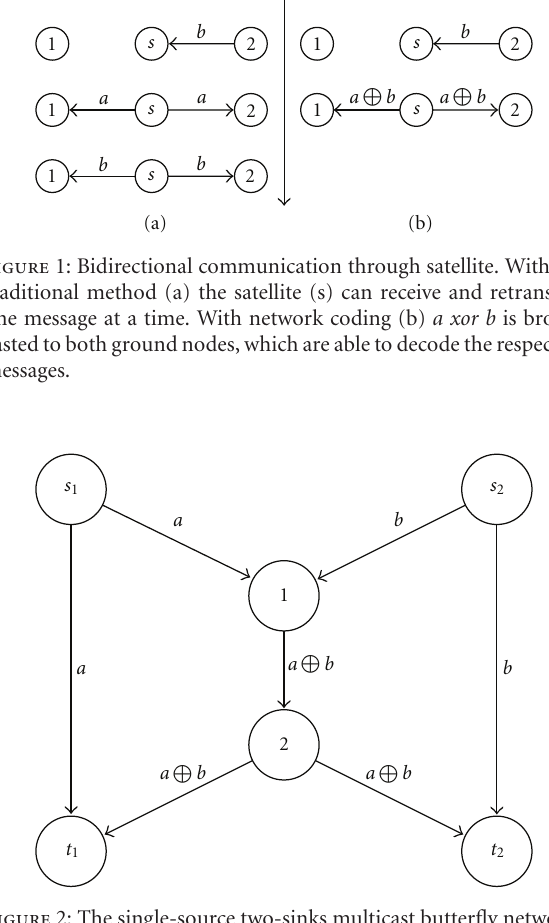
based on information vectors. Determining the coding oper- ations for specific networks allows transmission with desired properties, especially in the case of coding for error